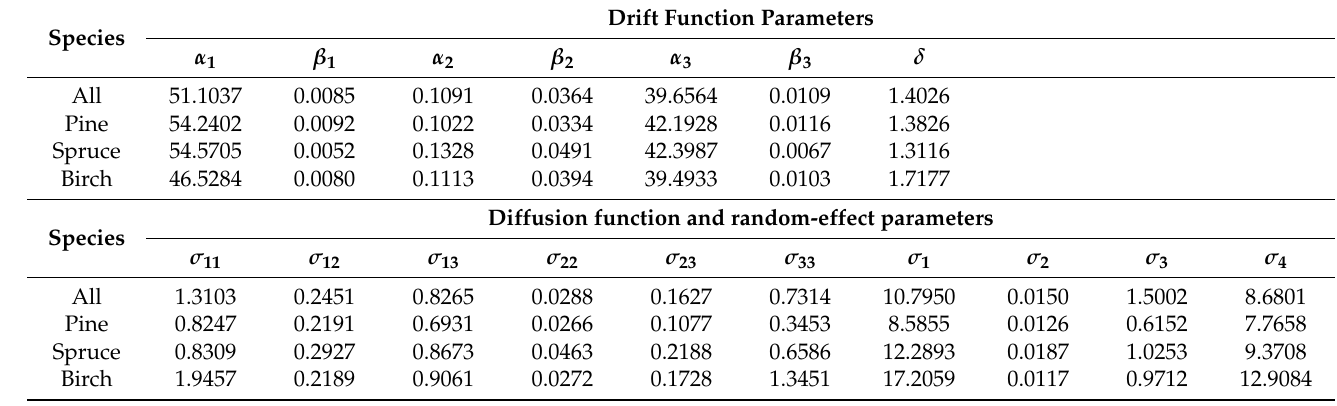
Table 2. Vasicek–Gompertz–Vasicek-type Equation (1) for diameter, area, and height: parameter estimates. Drift Function